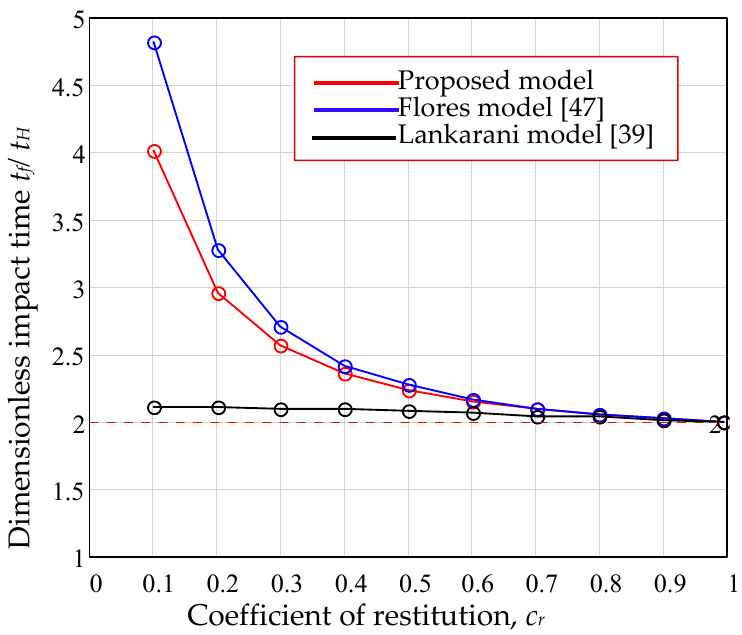
Figure 24. The variation of impact time ( t f ) versus coefficient of restitution ( c r ).